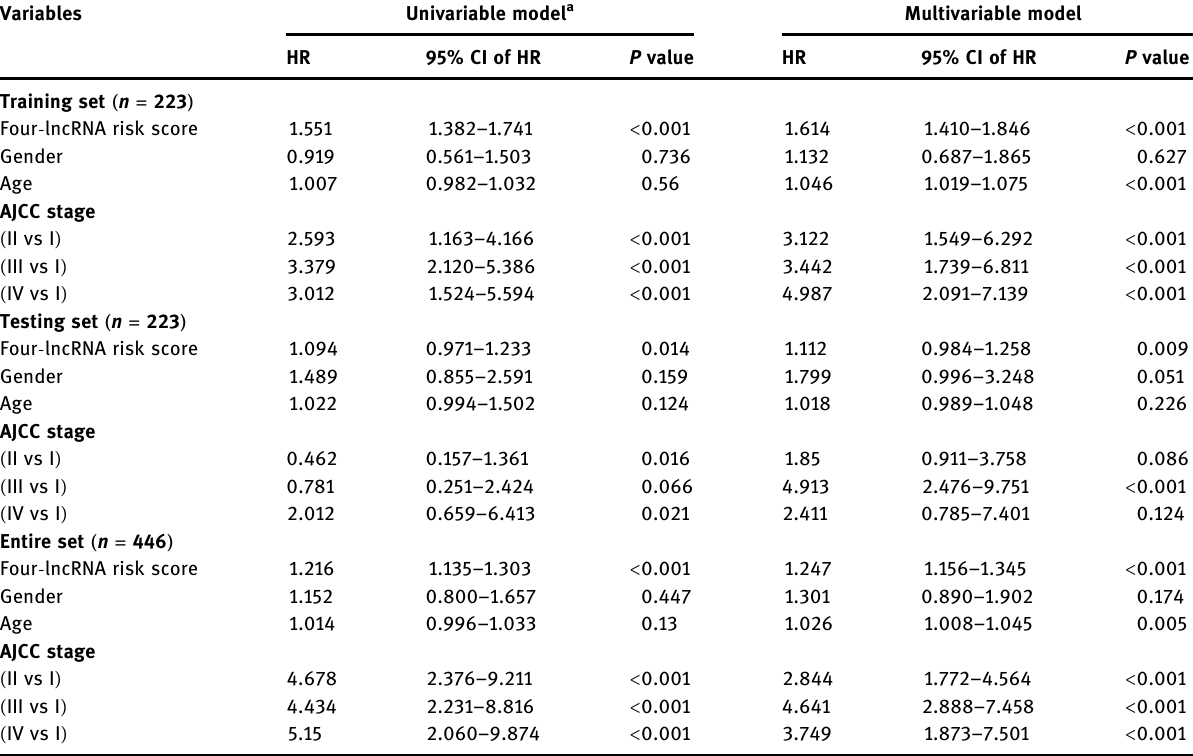
Table 3: Univariable and multivariable Cox regression analyses in each data set Variables Univariable model